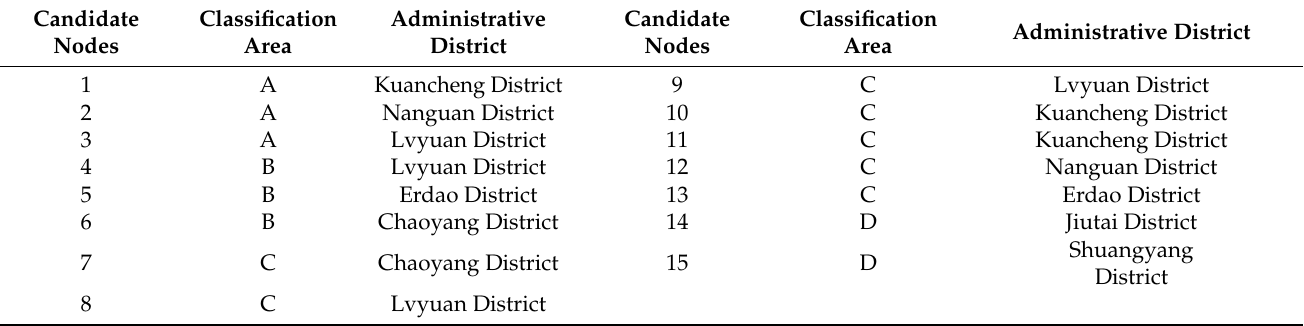
Table 5. Classification regions and administrative regions to which each candidate node